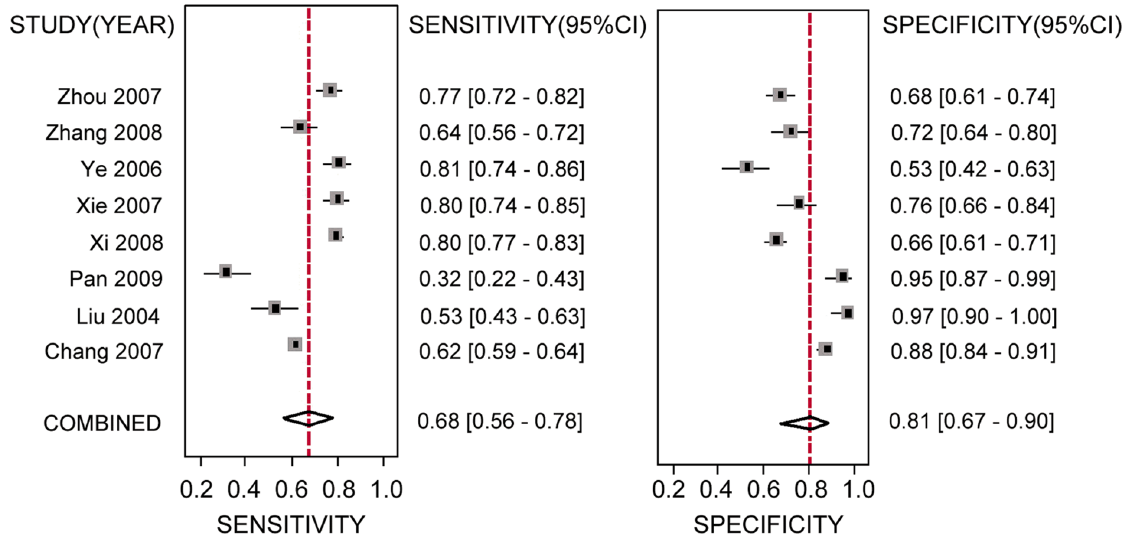
Figure 3. Forest plots of eight studies on a TLC threshold of 1500 cells/mm 3 for predicting a CD4 cell count , 350 cells/mm 3 . 95% confidence intervals (CIs) of sensitivity and specificity are in parentheses. The figure shows the estimated sensitivity and specificity of the study (square) with its 95% confidence interval (horizontal line). The pooled sensitivity and specificity were 0.68 (95 CI%, 0.56–0.78) and 0.81(95% CI, 0.67– 0.90),